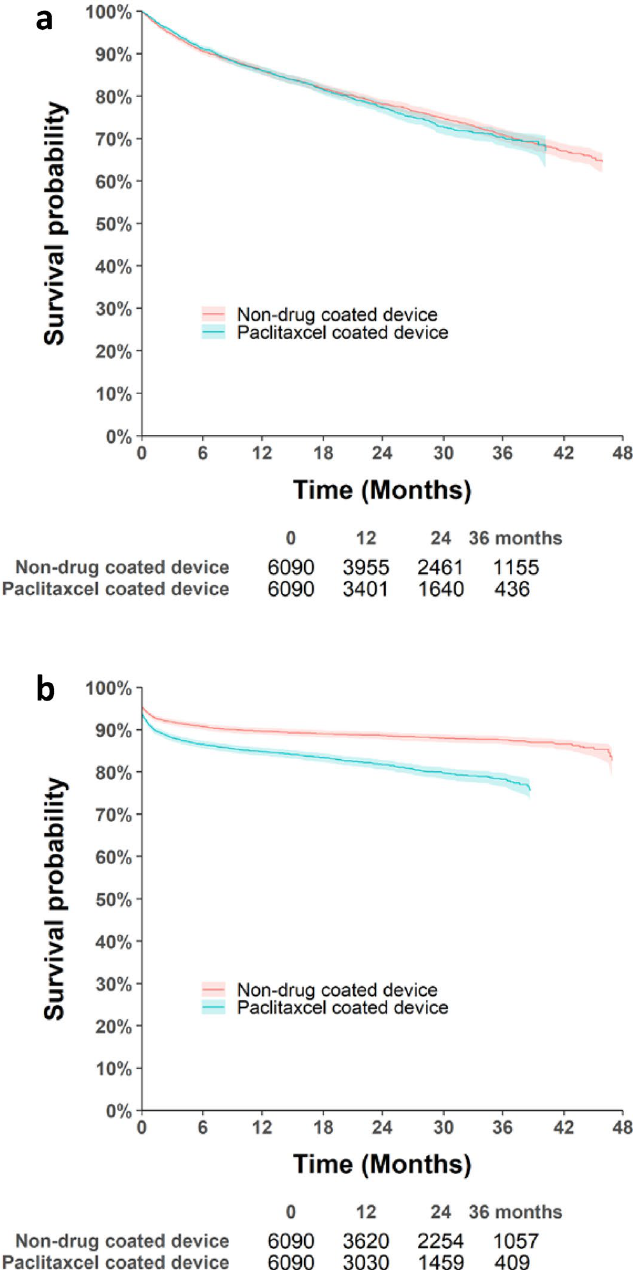
Figure 2. Cumulative Kaplan–Meier estimate of ( a ) all-cause mortality and ( b ) amputation-free survival in patients treated with the paclitaxel-coated and non-paclitaxel-coated devices after propensity score